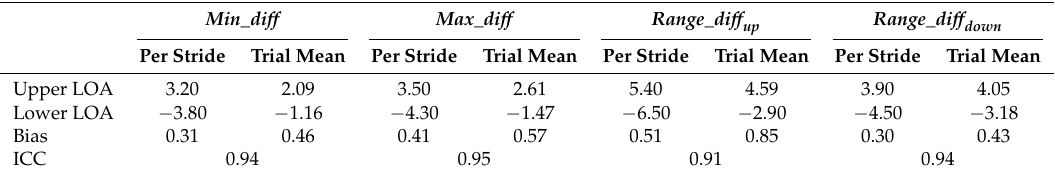
Table 9. Summary of measurement agreement statistics for the sacrum (values in